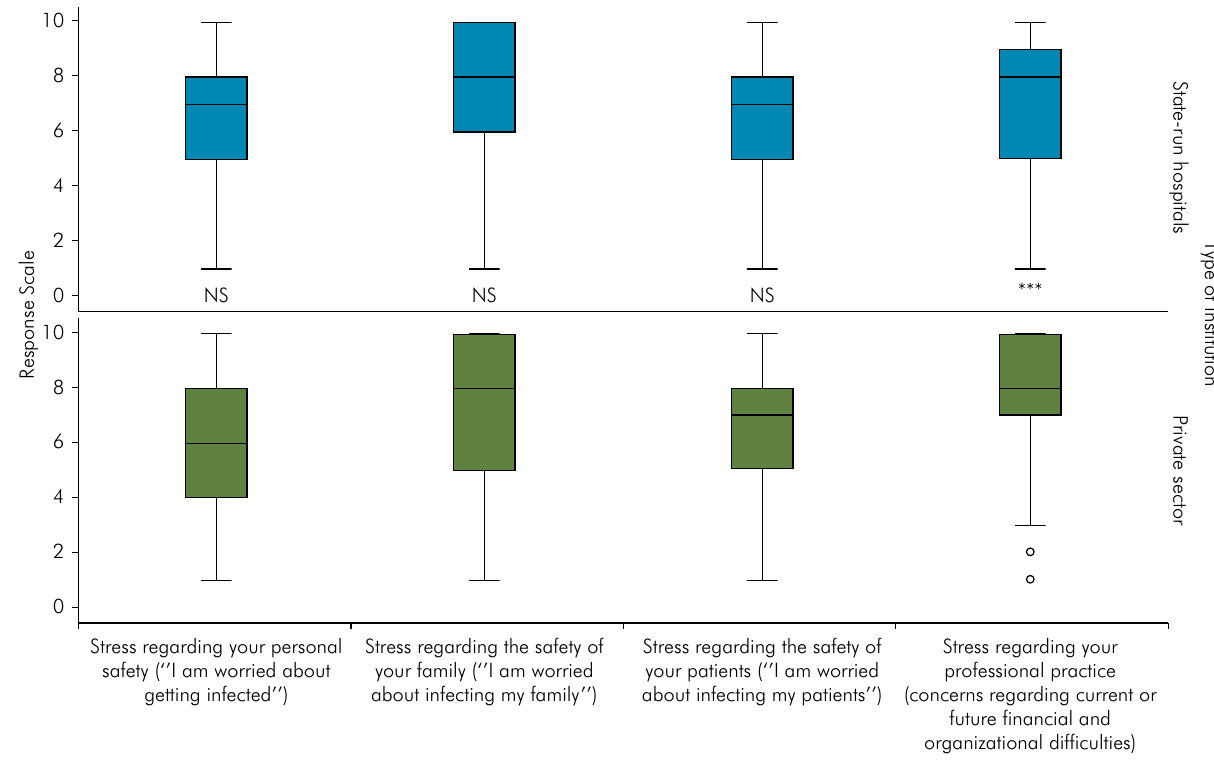
Figure 4. Box-plot representing the statistical relation of type of institution and stress scale responses. [Data represented as median (horizontal bars inside the box) and range (Y-error bars). *** = represents significant difference (p < 0.001). NS = Non-significant (p >